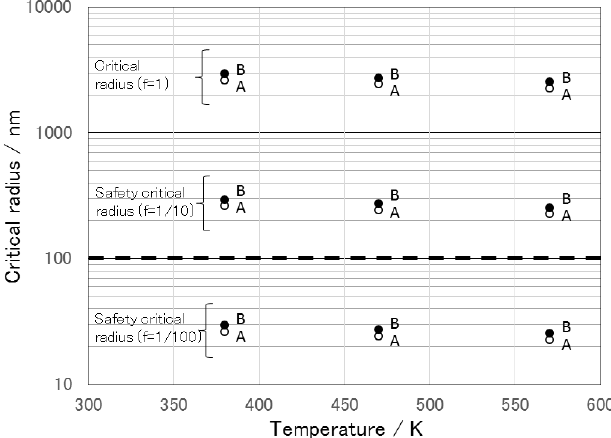
Figure 1. Temperature dependence of safety critical radius, r N sc , for titanium nanoparticles in liquid Na; open circle: slip boundary condition ( A ); and solid circle: stick boundary condition ( B